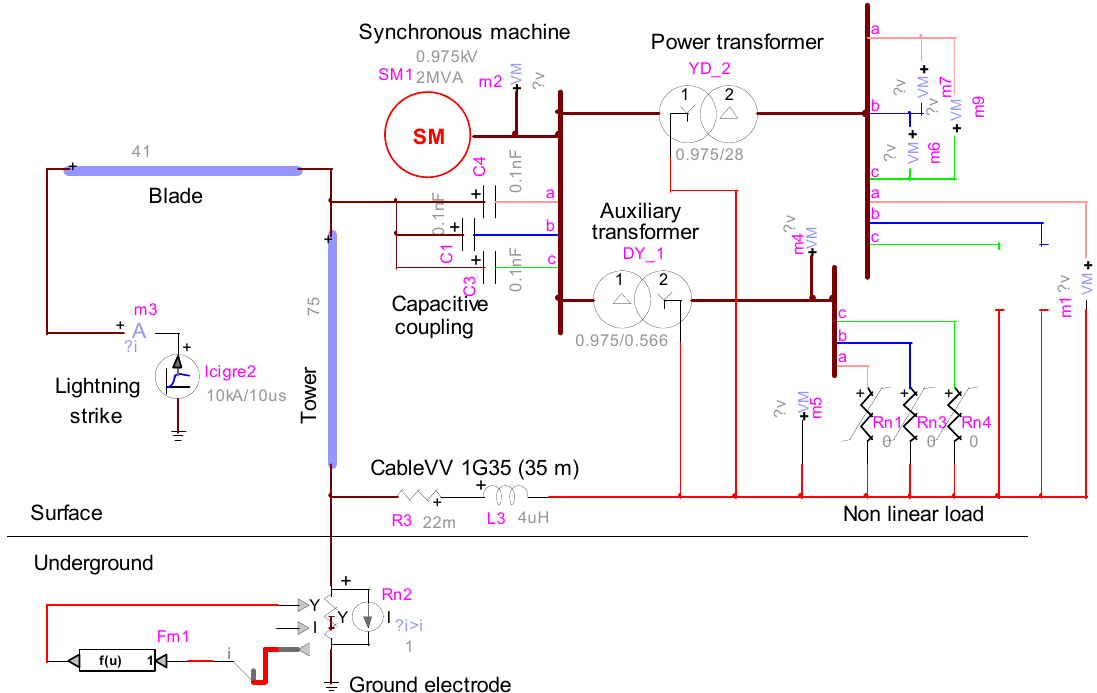
Figure 5. EMTP-RV circuit without